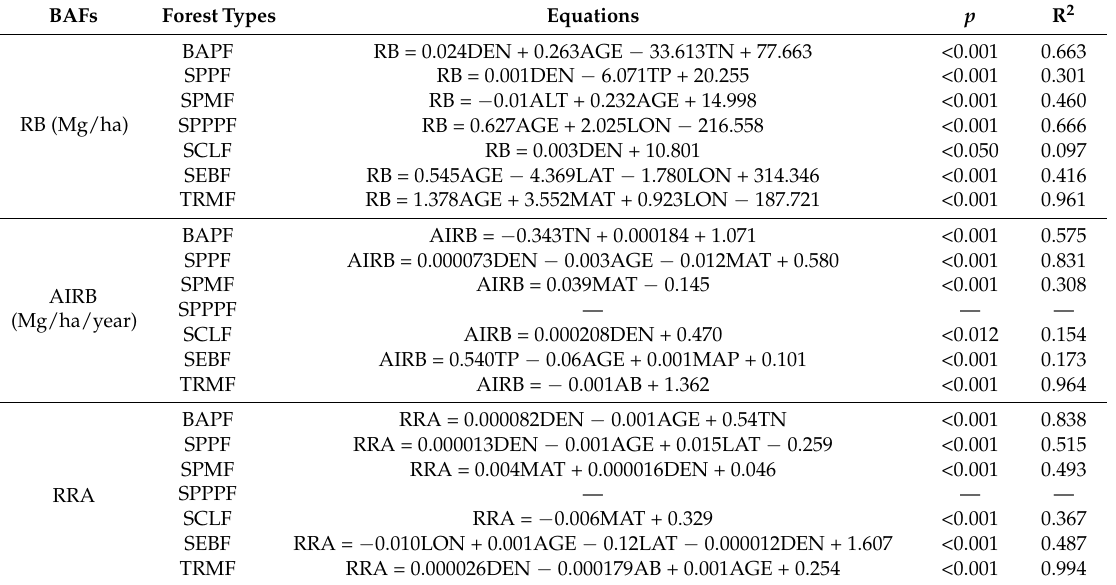
Table 3. Stepwise multiple regressions (SMR) between stand forest root biomass (RB, Mg/ha), annual increment of root biomass (AIRB, Mg/ha/year), ratio of root biomass per ha and aboveground biomass per ha (RRA) with environmental factors and stand characteristics across different forest types in southwest